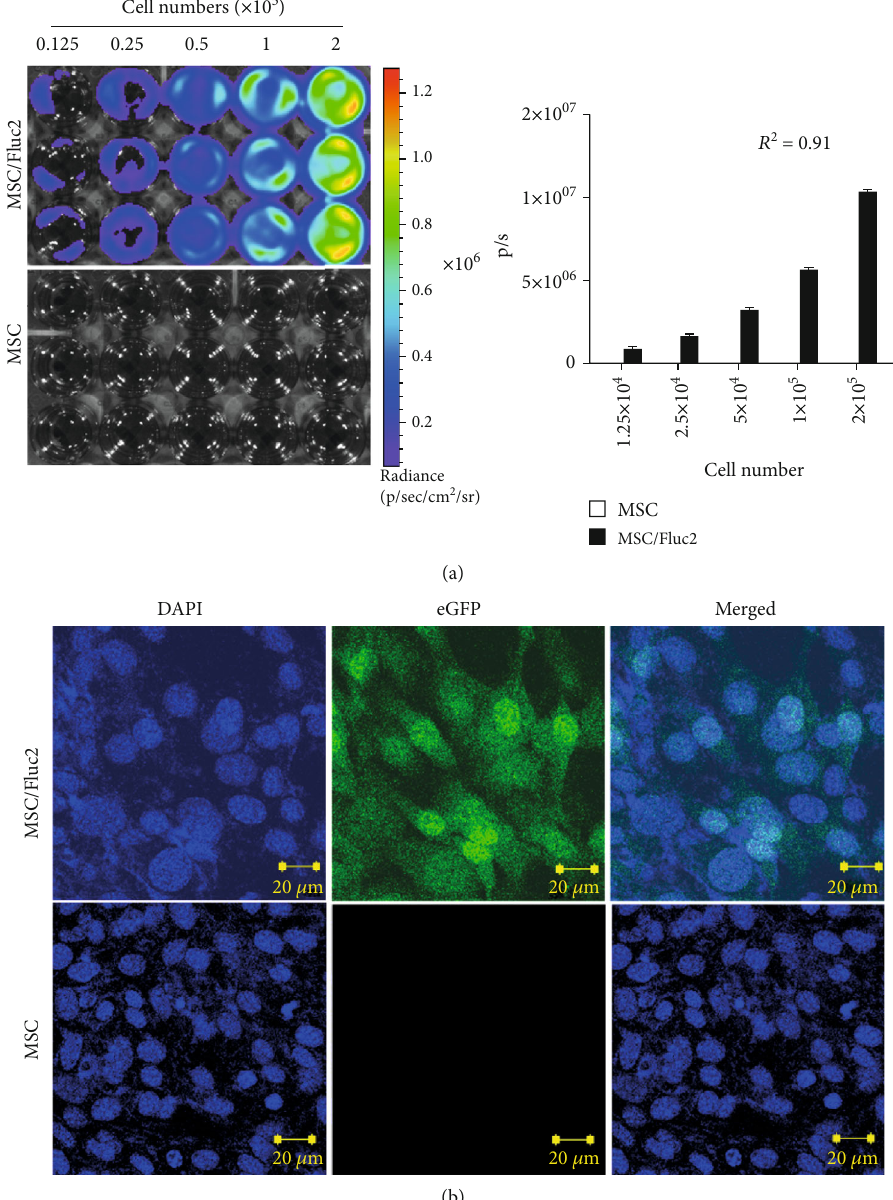
Figure 2: Characterization of MSC/Fluc2 cells (a) BLI and quantitation of Fluc activity in transduced MSCs (MSC/Fluc2) at various concentrations. (b) eGFP confocal microscopy in transduced MSCs